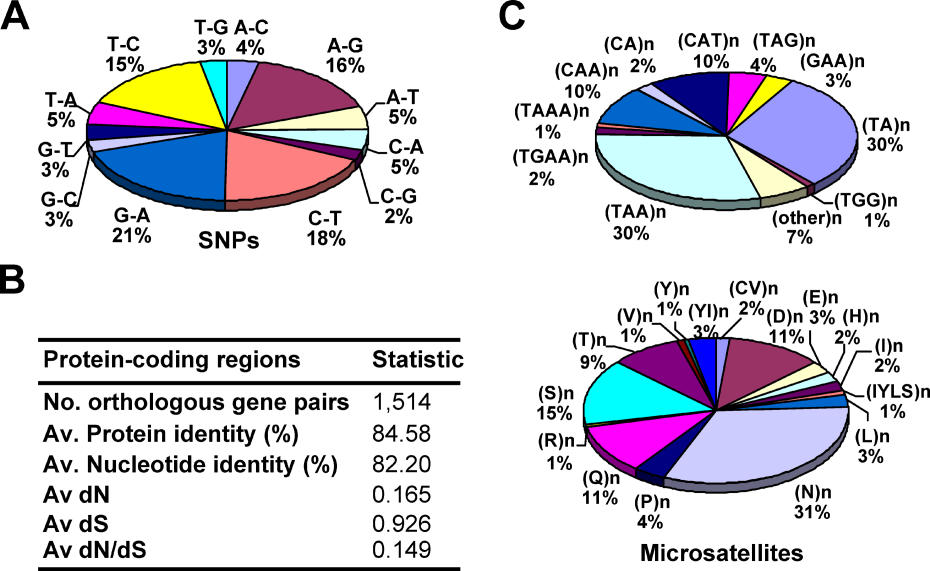
Genetic Polymorphisms in S. japonicum Genes(A) The distribution of nucleotide transition and transversion due to SNPs. The bars between single-letter nucleotides indicate the substitution of the latter base for the former.(B) Summary of the dN/dS analysis. The average dN/dS ratios and identities of coding regions are shown for all orthologous genes between S. japonicum and S. mansoni. Av, average.(C) The pattern distributions of the repeated amino acid residues deduced from microsatellite repeats within protein-encoding regions.